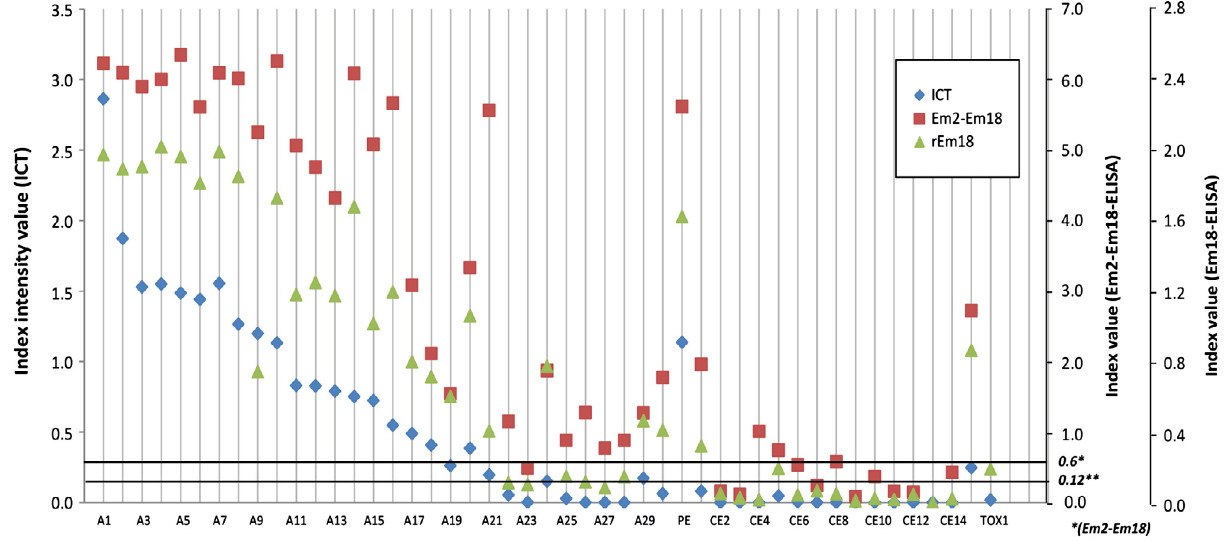
Figure 1. Immunological response to E. multilocularis antigens. Comparison of rEm18-ICT with ELISA rEm18 (OD values) and Em2-Em18 (index values) for AE (alveolar echinococcosis), CE (cystic echinococcosis), PE (polycystic echinococcosis), and toxocariasis (TOX1) cases. The thin dotted line represents the Em2-Em18 index threshold and the thick dotted line represents the rEm18 OD threshold; *Em2-Em18 threshold index, **rEm18 threshold OD value.